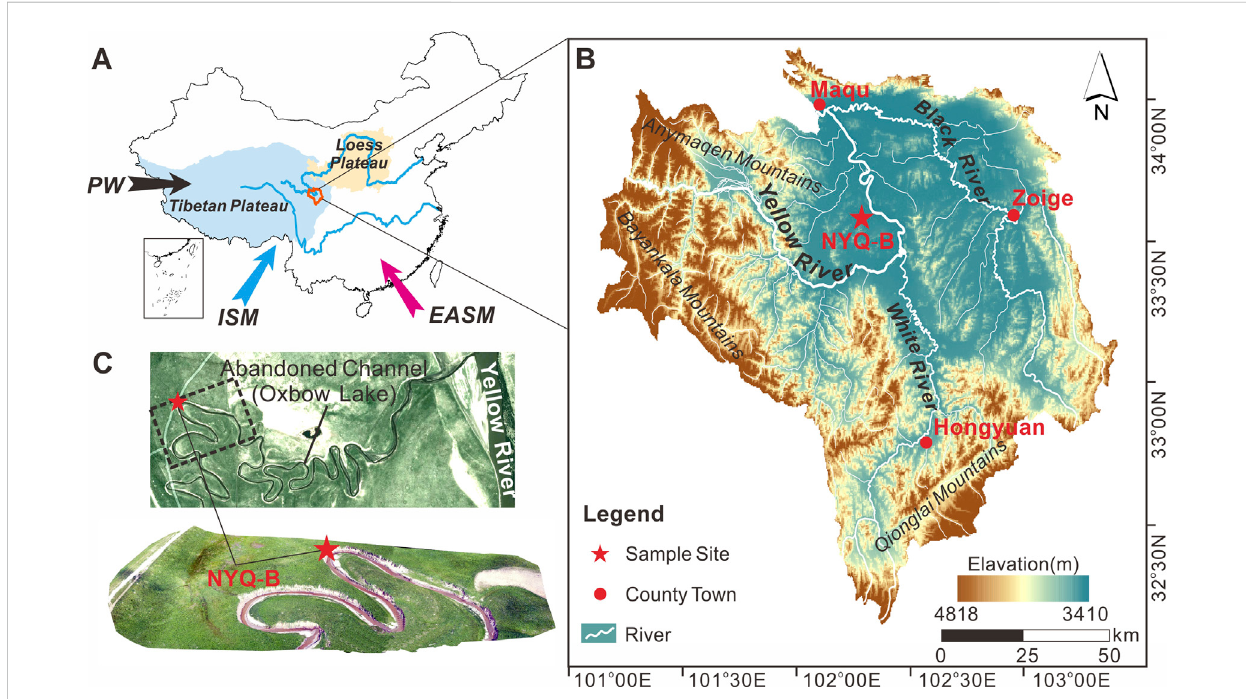
FIGURE 1 Overview of the study area. (A) Map shows the Zoige Basin (the outlined area) on the NE Tibetan Plateau; Abbreviation: PW, Prevailing Westerlies; ISM,IndiansummerMonsoon;EASM,EastAsiansummerMonsoon. (B) GeomorphologyoftheZoigeBasinandthelocationofthepaleo-oxbowlake fi llat NYQ-B site in the Yellow River within the Zoige Basin. (C) The satellite image (Google Earth) and our UAV aerial image shows the location of the paleo- oxbow lake fi ll at NYQ-B site in the Yellow River within the Zoige